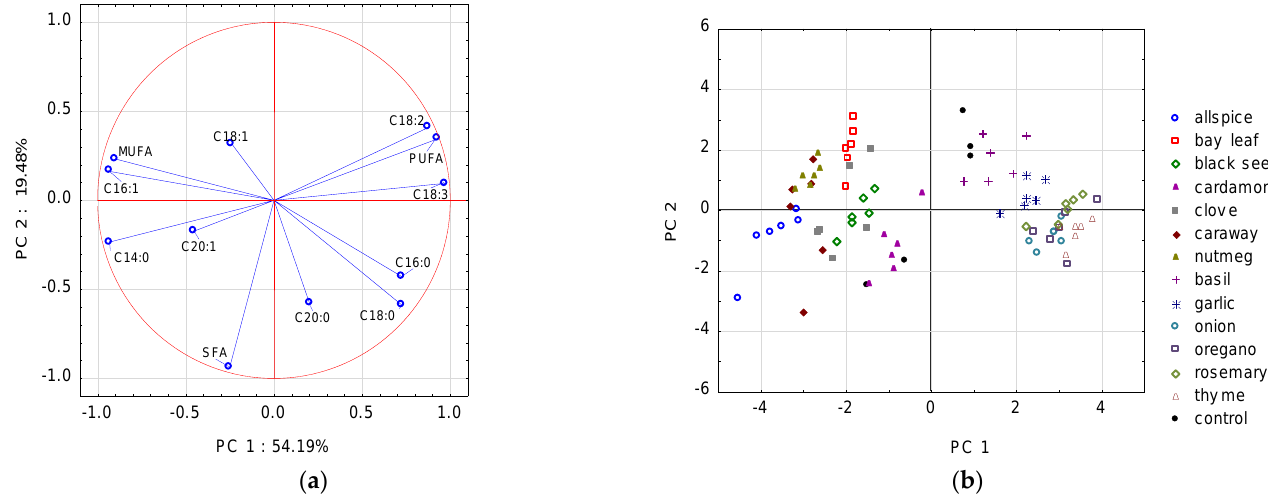
Figure 1. Projections of the ( a ) variables (fatty acids) and ( b ) scores (plant extracts) for raw chicken meat samples onto the factor plane defined by principal components (PC1 and PC2).